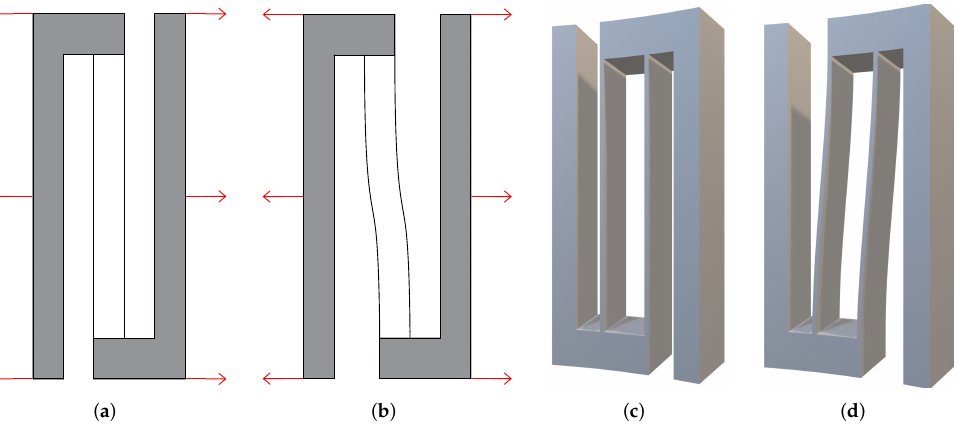
Figure 2. The decoupling mechanism. ( a ) 2D decoupling mechanism. ( b ) Deformed 2D decoupling mechanism. ( c ) 3D decoupling mechanism (load is added in the direction perpendicular to the radius direction). ( d ) Deformed 3D decoupling mechanism.